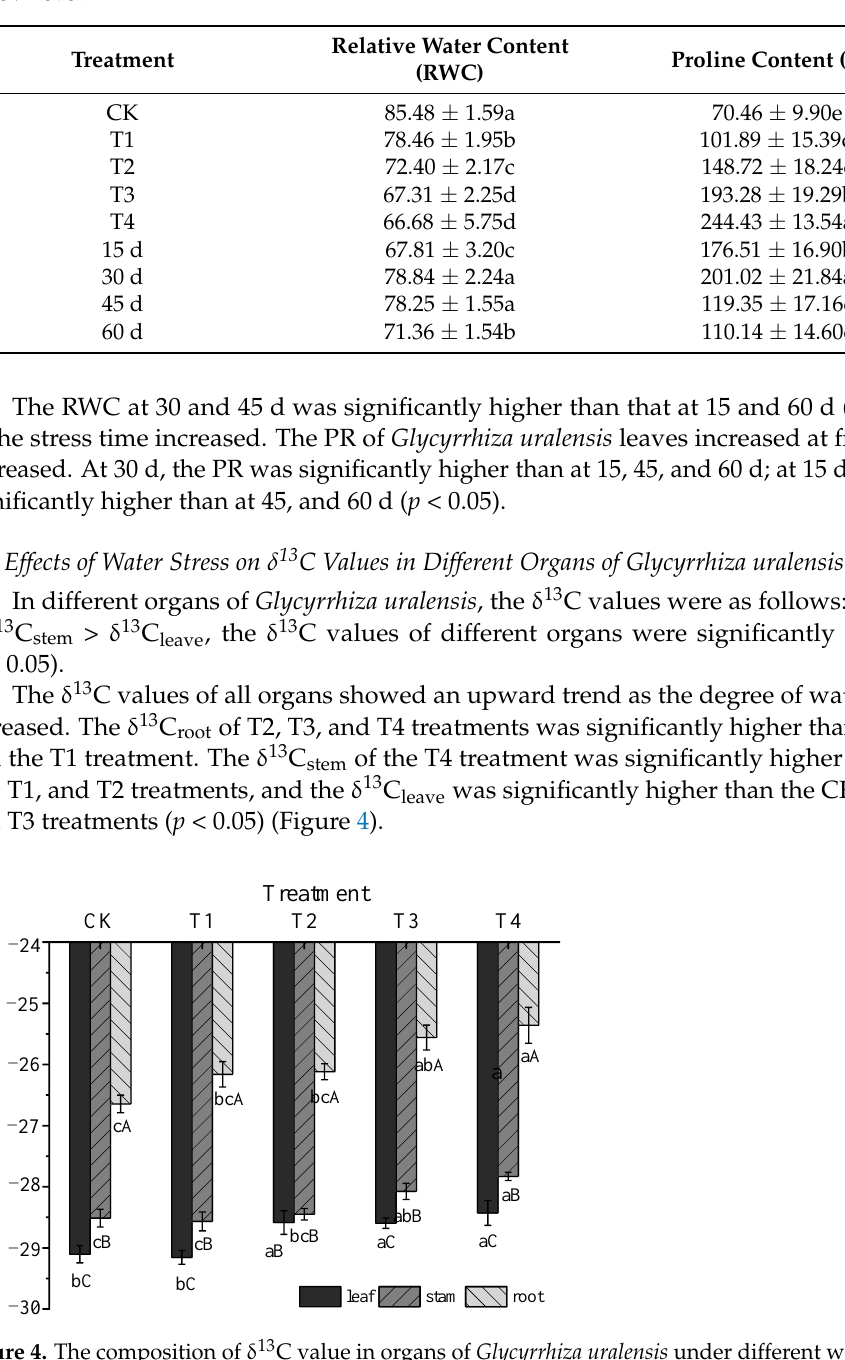
Figure 4. The composition of δ 13 C value in organs of Glycyrrhiza uralensis under different water stress conditions. Different lowercase letters indicate a significant difference among treatments at the 5% level. Different capital letters indicate a significant difference at a 5% level between different organs.